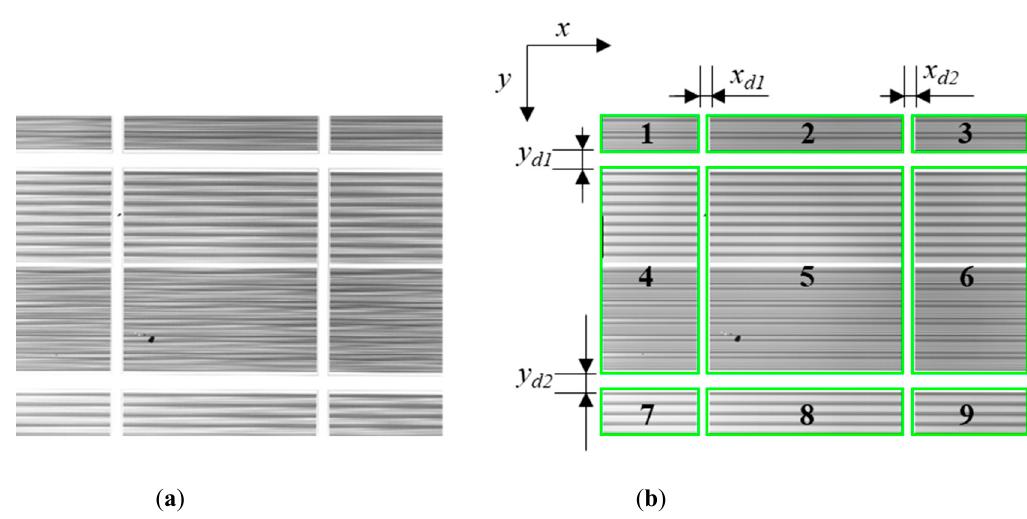
Figure 6. ( a ) The original image with defects in the middle block and the intervals; ( b ) the block numbers and the widths of the intervals are illustrated.